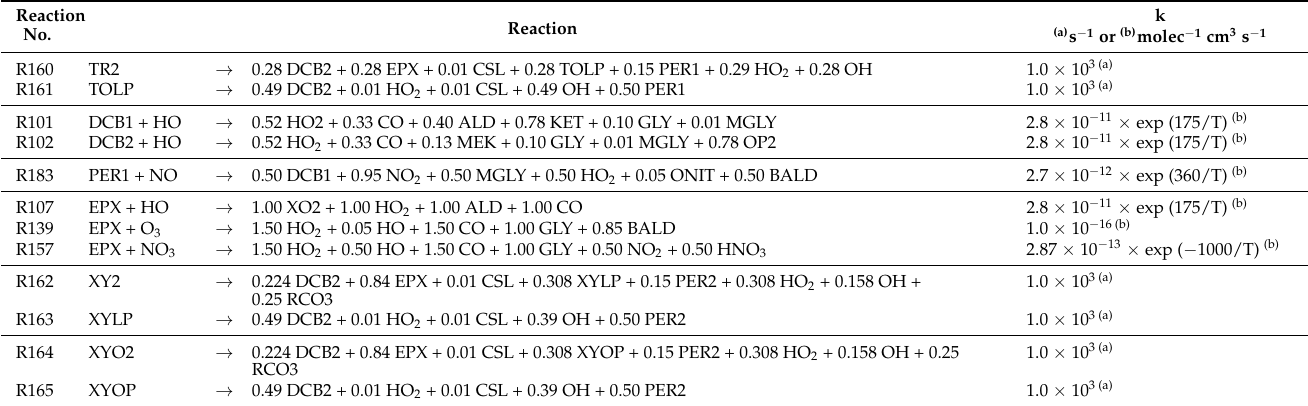
Table A1. Original RACM2 reactions.